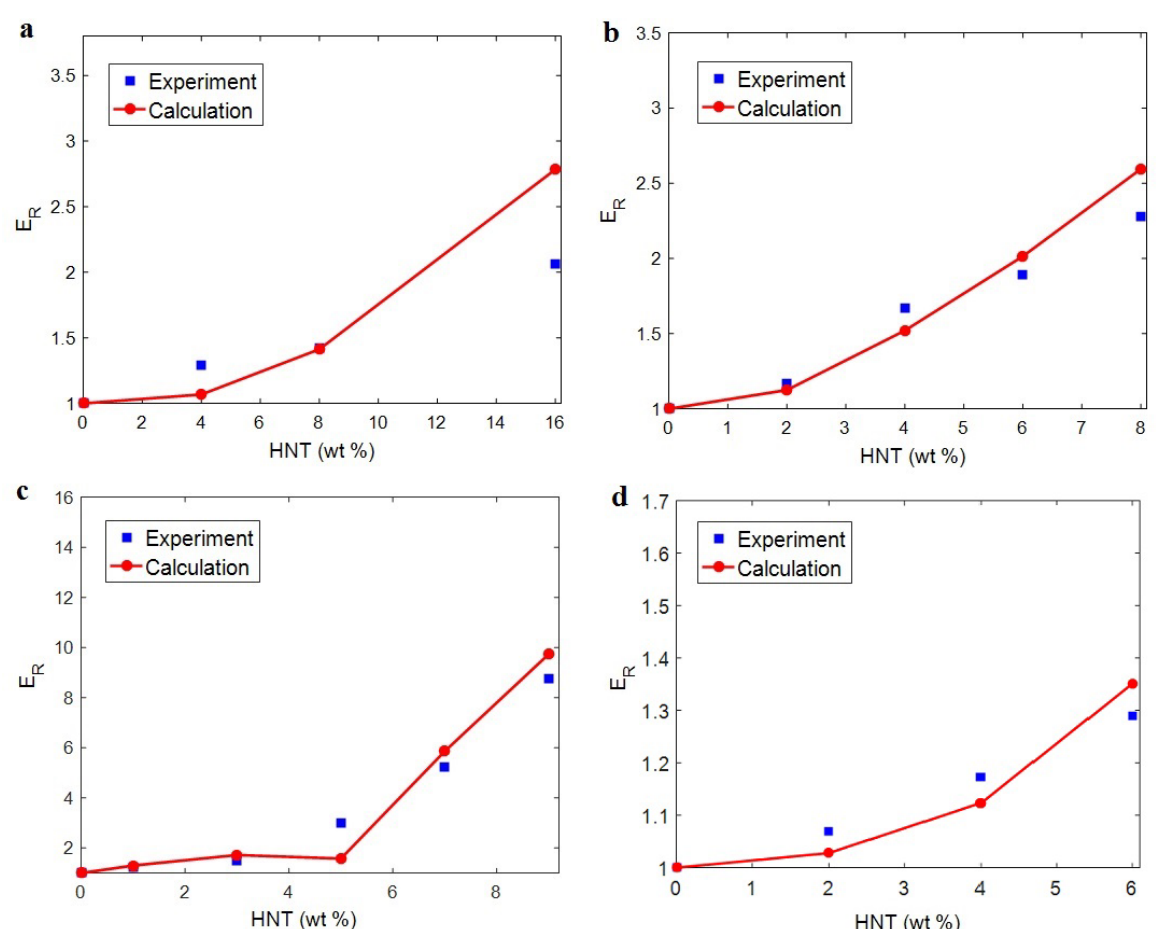
Figure 10. Experimental “ E R ” and the calculations of established technique for ( a ) PA12 [66], ( b ) cellulose [67], ( c ) starch [68] and ( d ) PLA [51] systems containing HNT.